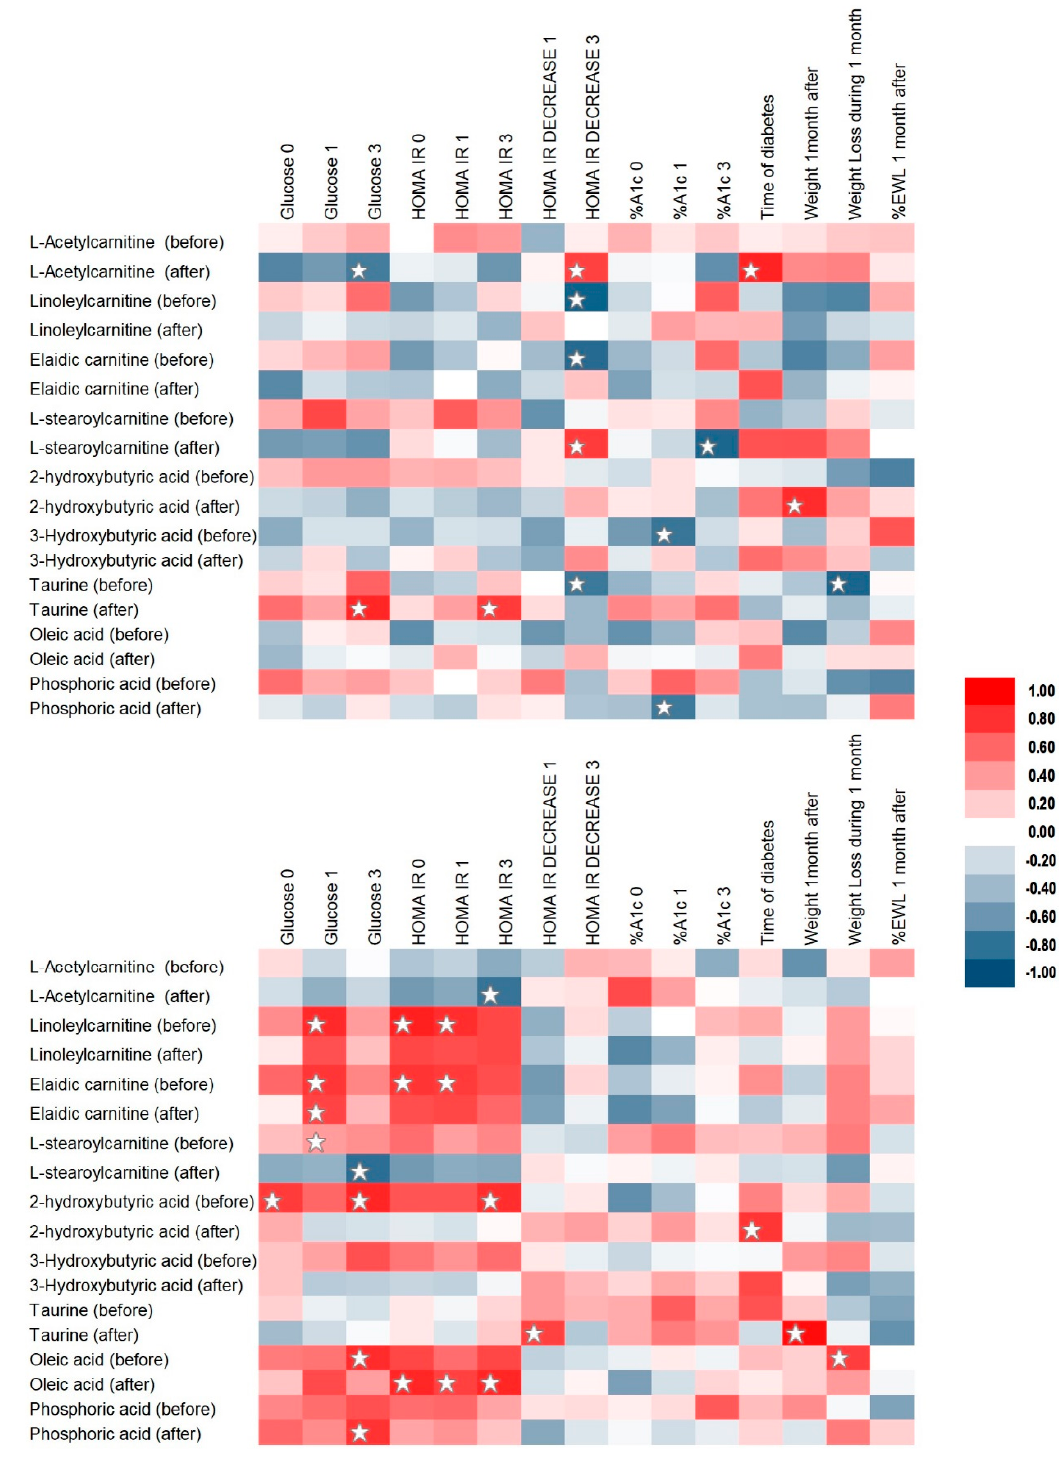
Figure 3. Selected Spearman correlation analysis results presented as heat maps for quicker ( top ) and slower ( bottom ) T2DM remission groups. Statistically significant correlations are marked with ☆ . Time points: 0—before the surgery, 1—one month after, 3—three months after; Metabolites: “before”—before the surgery, “after”—one month post-surgery.